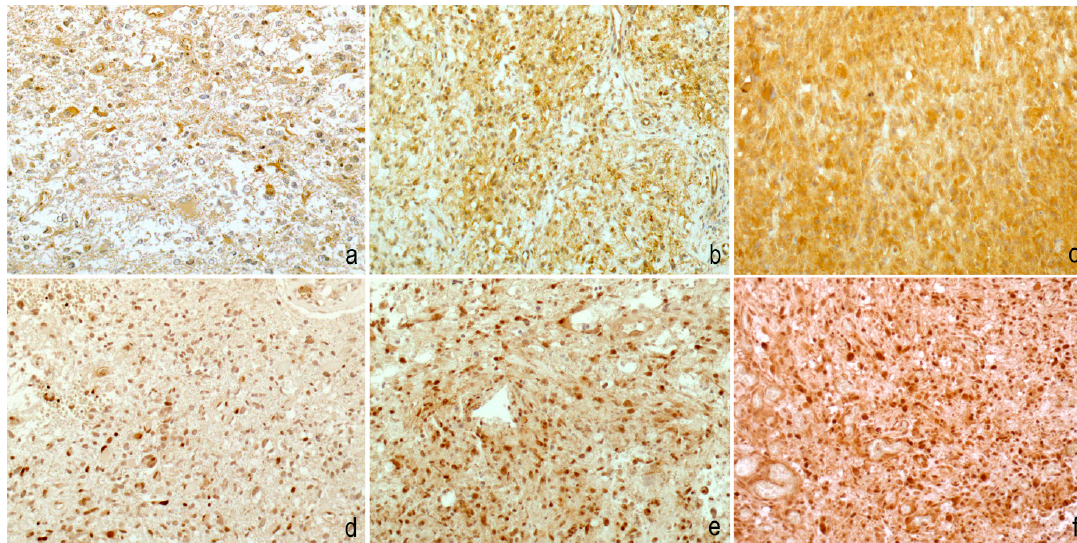
Figure 1. Immunohistochemical staining was evaluated with a four-tiered scoring system for both DJ-1 ( a – c ) and Beclin ( d – f ). DJ-1 nuclear and cytoplasmic/nuclear Beclin reactivity was observed in <10% of neoplastic cells in cases with a score of 1, in 10–50% of neoplastic cells in cases with a score of 2 and in ≥ 50% of neoplastic cells in cases with a score of 3. Score 0 was used in the absence of staining (200× magnification).